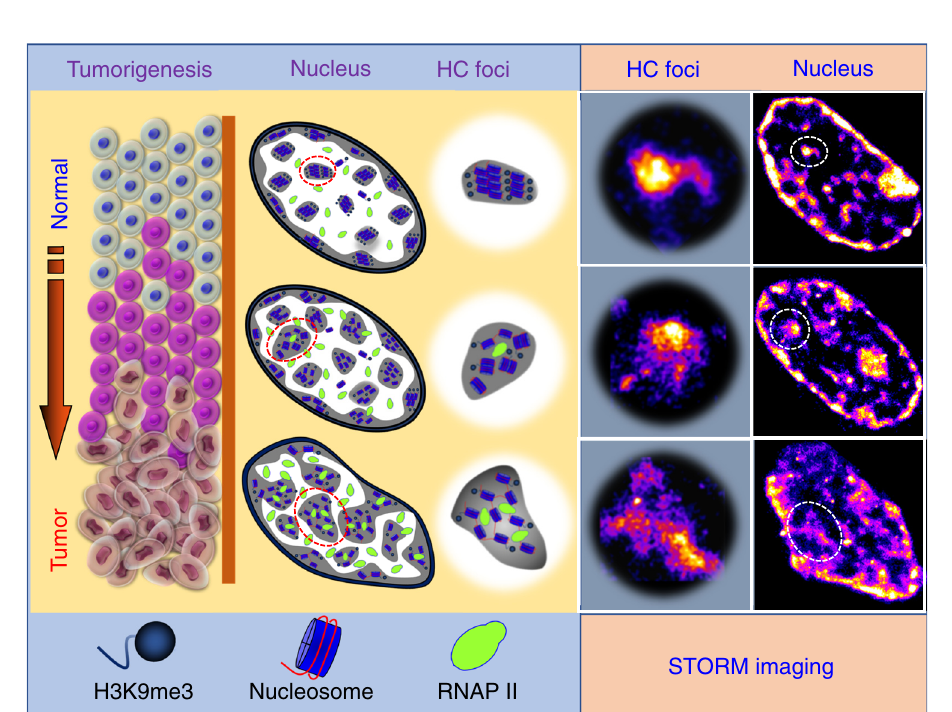
Fig. 8 Model to depict the molecular-scale heterochromatin structure in carcinogenesis. As normal cells transform into tumor cells in carcinogenesis, chromatin folding becomes gradually de-compacted and fragmented accompanied with enlarged heterochromatin foci, which increases enhanced formation of transcription factories and genomic